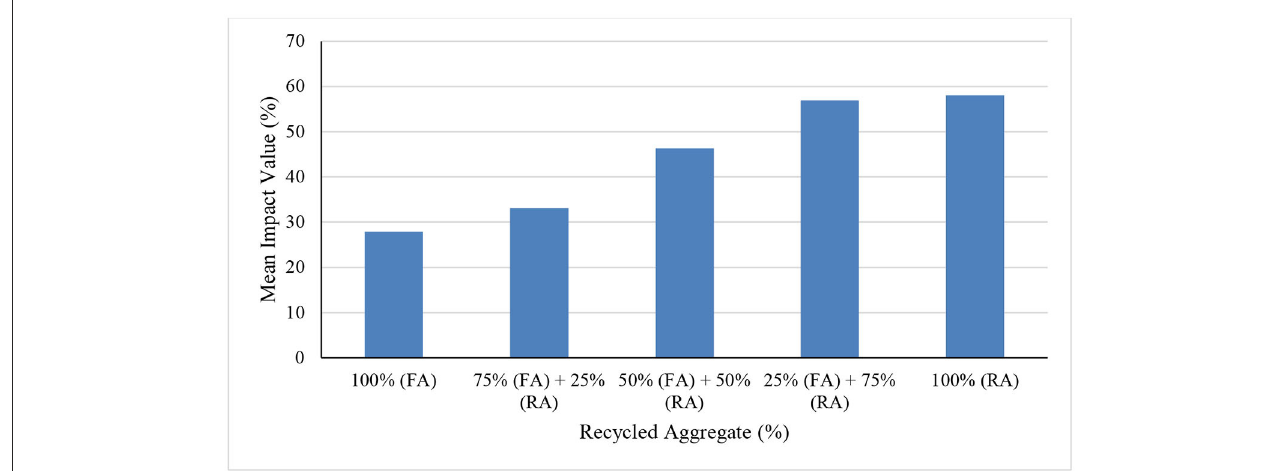
FIGURE5 Recycled aggregates impact value at different percentages of replacement.